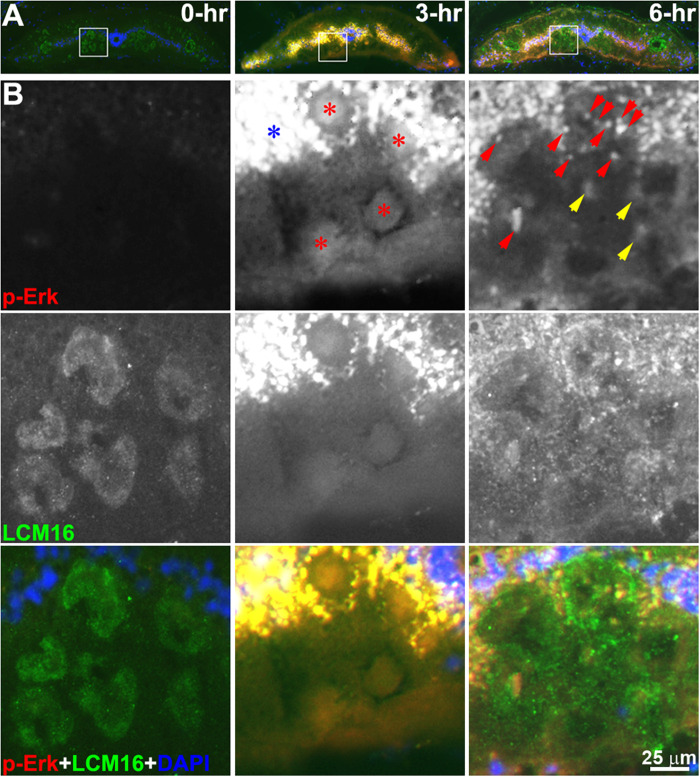
p-Erk staining becomes localized in granules by 6 h post-TX. (A) superimposed triple staining of cross sections at the level of the 6.5th gill in control (0-h) and transected (7th gill) spinal cords (3-h and 6-h). (B) enlarged squares in panel (A). Two monochromic images in each column represent p-Erk and LCM16 labeling, respectively. The color images at the bottom is superimposed of p-Erk, LCM16 and DAPI staining. Diffuse p-Erk staining was found inside axons at 3 h post-TX (red stars), and in cells of the gray matter (blue star). Both granules (red arrowheads) and diffuse stain (yellow arrowheads) were found in axons of transected spinal cord at 6-h post-TX. Red, p-Erk; Green, LCM16; Blue, DAPI.